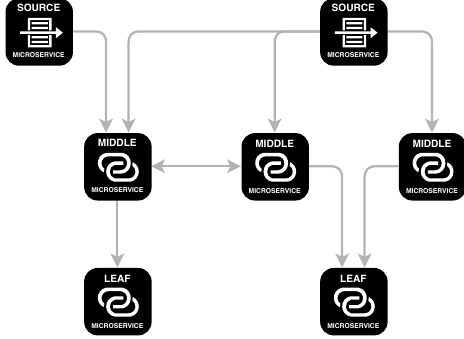
Figure 1. Example of an execution graph in C ATENAE